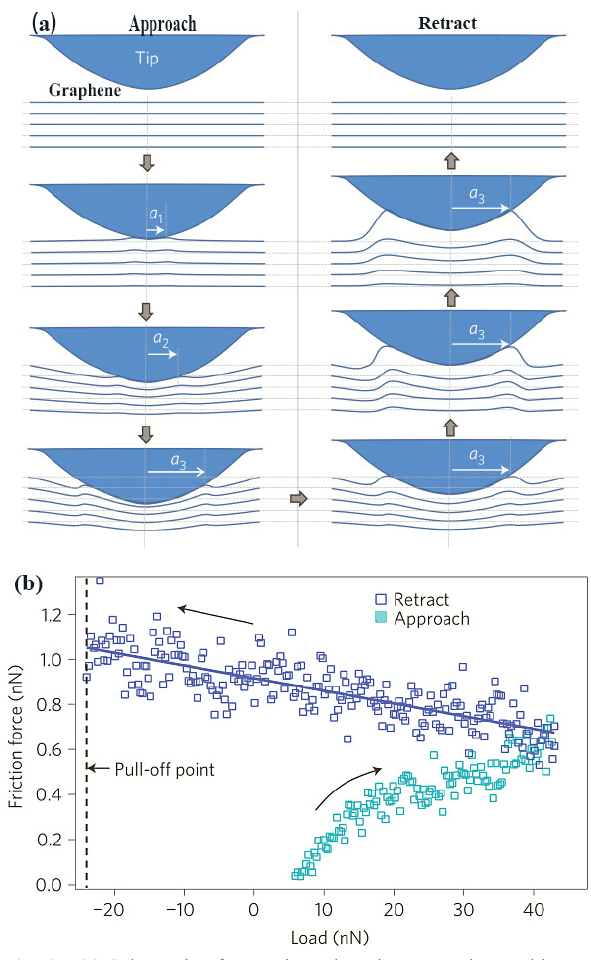
Fig. 4 (a) Schematic of retraction when tip approaches and leaves graphene surface; (b) unusual frictional behavior at graphene surface. Reproduced with permission from Ref. [85], © Springer Nature